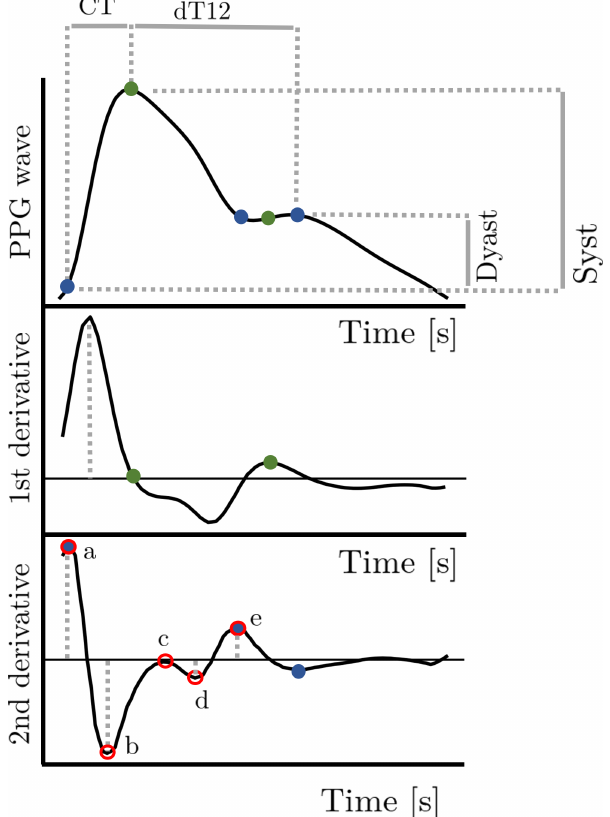
Figure 4. PPG signal and its first and second derivatives. Green points show the fiducial points identified through the first derivative analysis. Blue points show the fiducial points identified through the second derivative analysis. CT: Crest time. dT12: time between systolic and diastolic peaks. Dyast: diastolic peak amplitude. Syst: systolic peak amplitude. a, b, c, d, e: first five maxima and minima of the second